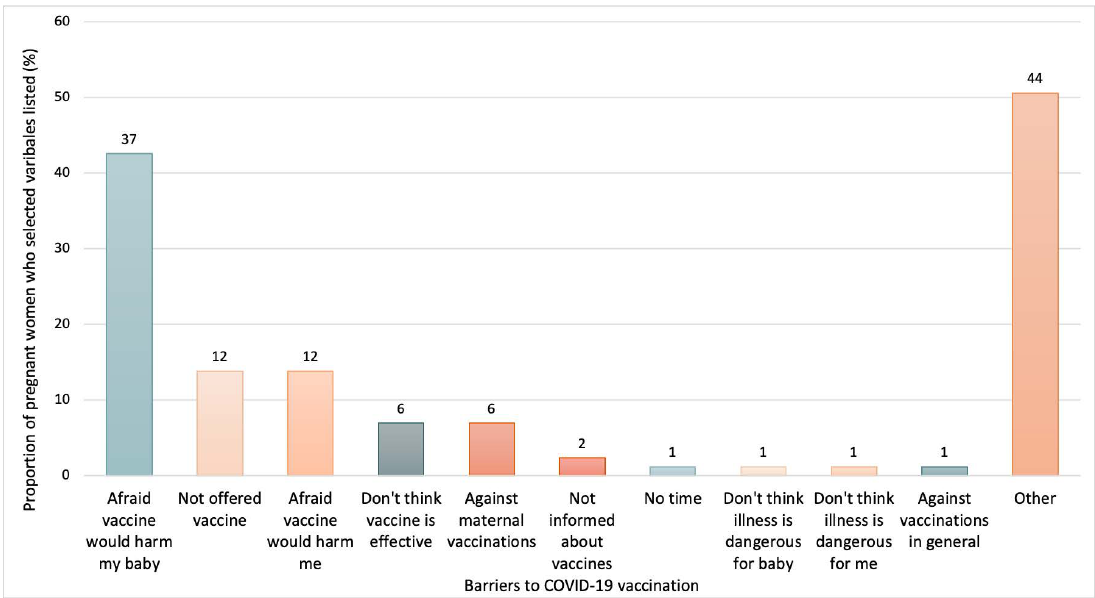
Figure 4. Barriers to vaccinating against COVID-19 during the current pregnancy reported by the pregnant women who rejected the maternal COVID-19 vaccination, N = 87. More than one answer possible. The figure shows data from participants enrolled during the period of the study after the effective implementation of national maternal COVID-19 recommendations, from 1 August 2021. No women selected the option ‘Religion or cultural